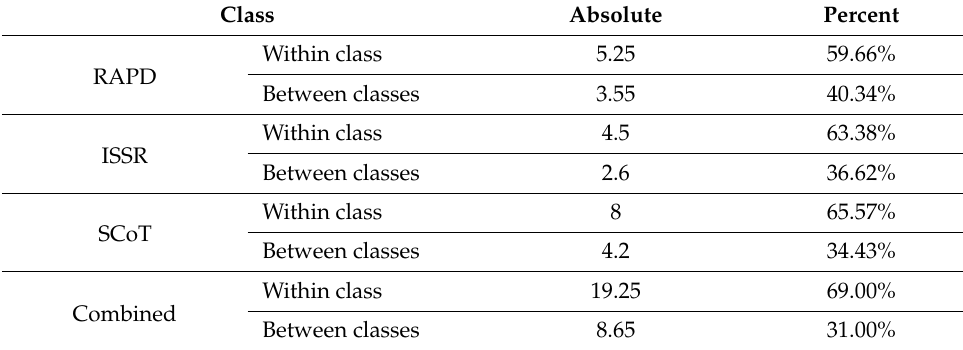
Table 6. Variance decomposition for the optimal